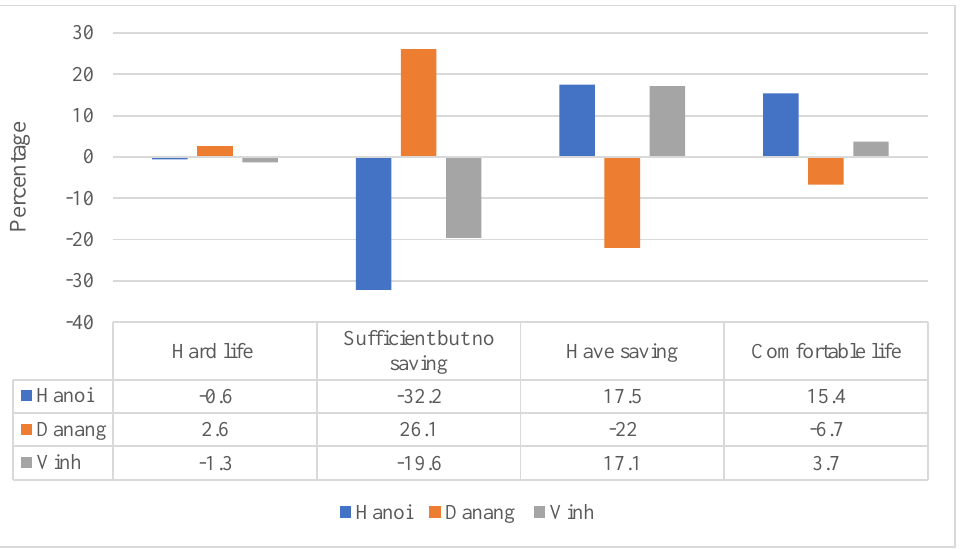
Figure 6. Life choices of surveyed households in the time before, during, or after land acquisition. Source: Households survey, 2019 and 2020.